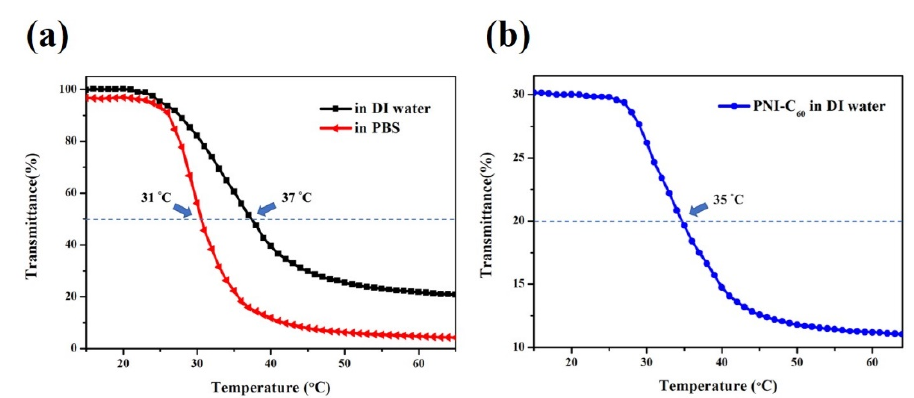
Figure 1. Temperature-dependent transmittance curves at 600 nm of ( a ) PNI-U-DPy in DI water and PBS; ( b ) C 60 -loaded PNI-U-DPy micelles (PNI-C 60 ). The blue dotted line represented the 50% transmittance value in the UV-Vis spectra.